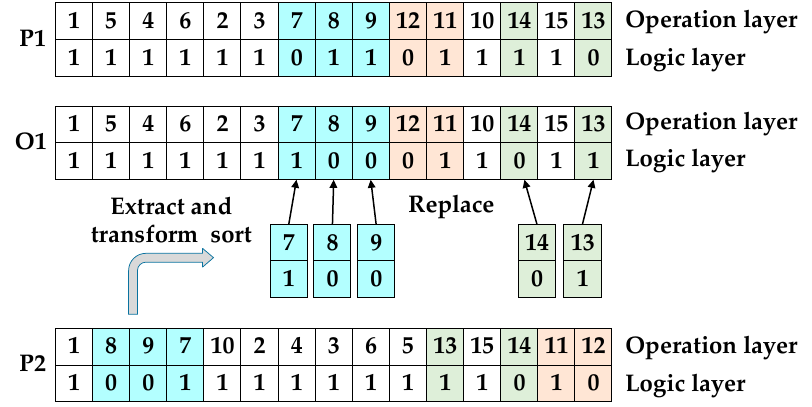
Figure 8. An example of crossover for machine layer.